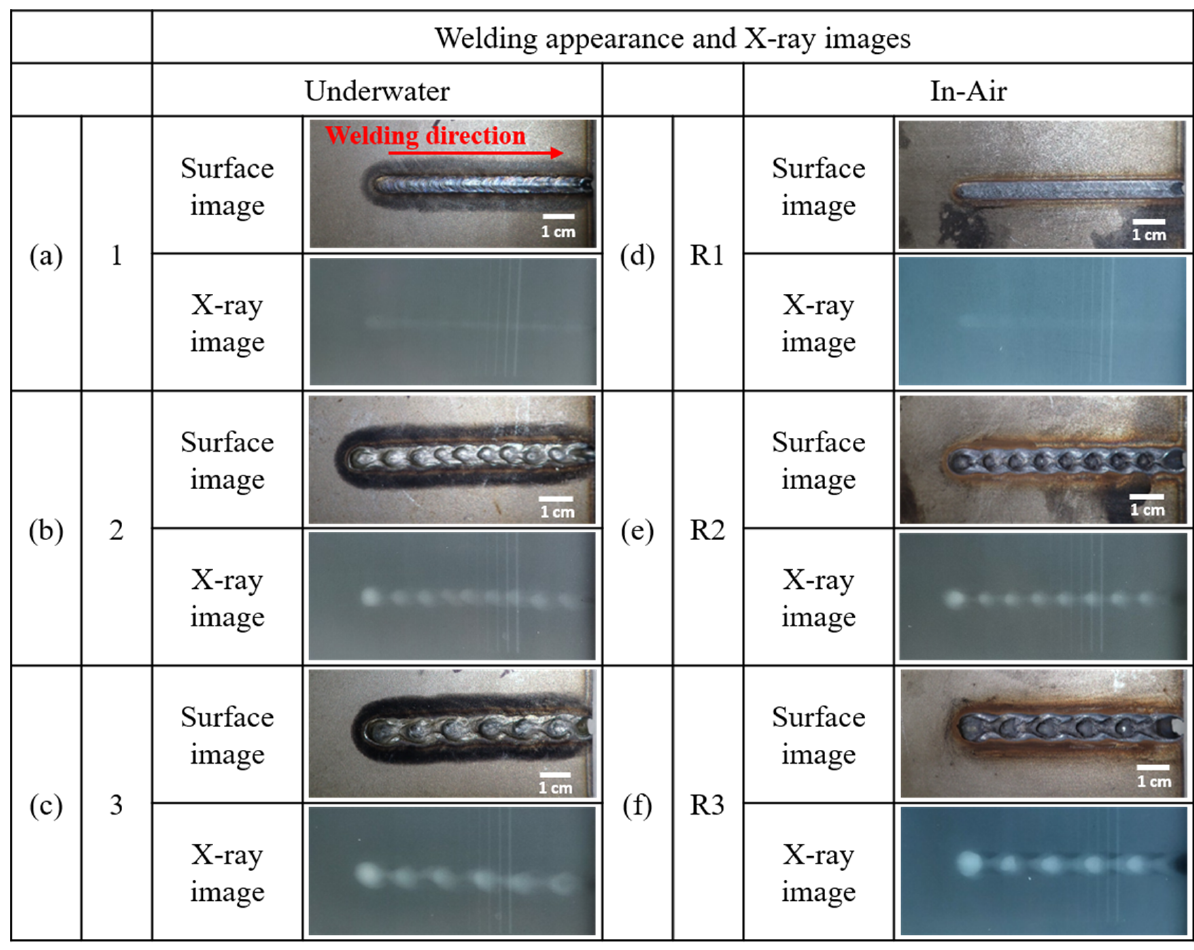
Figure 3. Photographs and X ‐ ray images of specimens welded underwater and in air using different laser powers: ( a ) 2 kW, ( b ) 4 kW, and ( c ) 6 kW (all underwater); ( d ) 2 kW, ( e ) 4 kW, and ( f ) 6 kW (all in air).